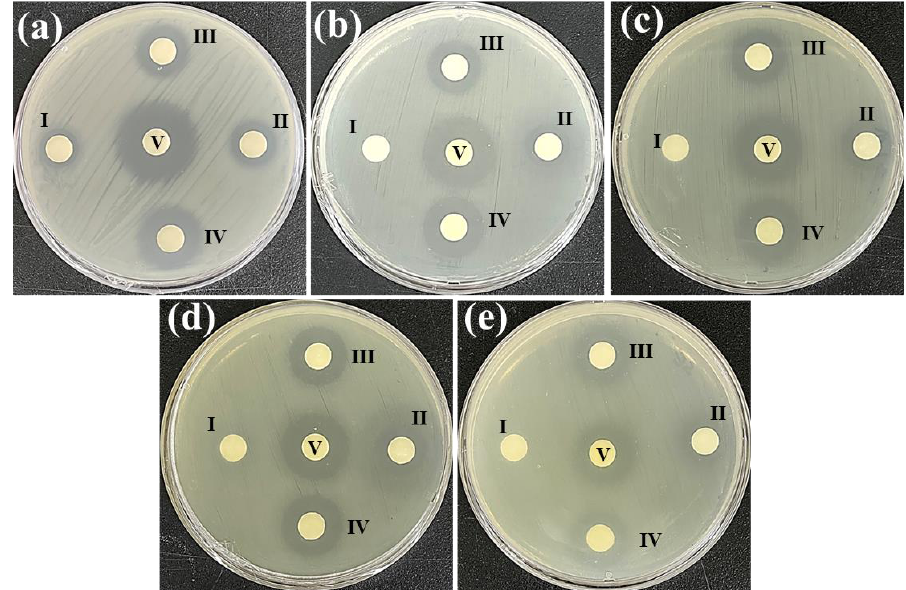
Figure 1. Antibacterial activity of the EAE-PL and EAE-PR against B. cereus ( a ), S. aureus ( b ), L. monocytogenes ( c ), E. coli ( d ), and S. enterica ( e ) in the disc diffusion assay. I (500 µg/mL) and II (1000 µg/mL) are the EAE-PL treatments. III (500 µg/mL) and IV (1000 µg/mL) are the EAE-PR treatments. V (100 µg/mL) is the experimental control (erythromycin (Ery)). Table 3. Summary of the antibacterial activity of the EAE-PL and EAE-PR against Gram-positive and Gram-negative pathogens compared to the standard antibiotic erythromycin (Ery) in the disc diffusion assay. The superscripts followed by the value represent significance ( p < 0.05) among the groups. Zone of Inhibition Bacterial Strains